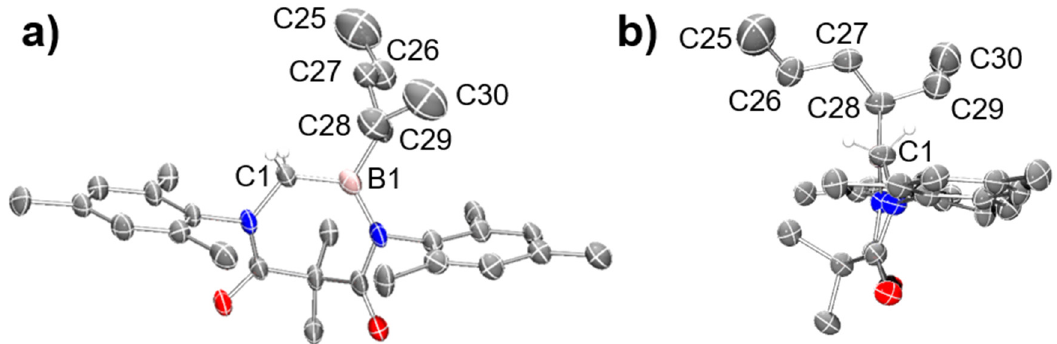
Figure 1. ( a ) Front and ( b ) side views of the Persistence of Vision Raytracer (POV-ray) representations of 10 showing ellipsoids at 50% probability. Most of the hydrogen atoms were omitted for clarity. Selected distances (Å) and angles ( ◦ ): C1–B1, 1.580 (9); B1–C28, 1.580 (9); C25–C26, 1.484 (14); C26–C27, 1.527 (10); C27–C28, 1.524 (10); C28–C29, 1.580 (10); C29–C30, 1.484 (12); C1–B1–C28, 116.0 (5). Gray = Carbon, Blue = Nitrogen, Red = Oxygen, Pink = Boron, White = Hydrogen.